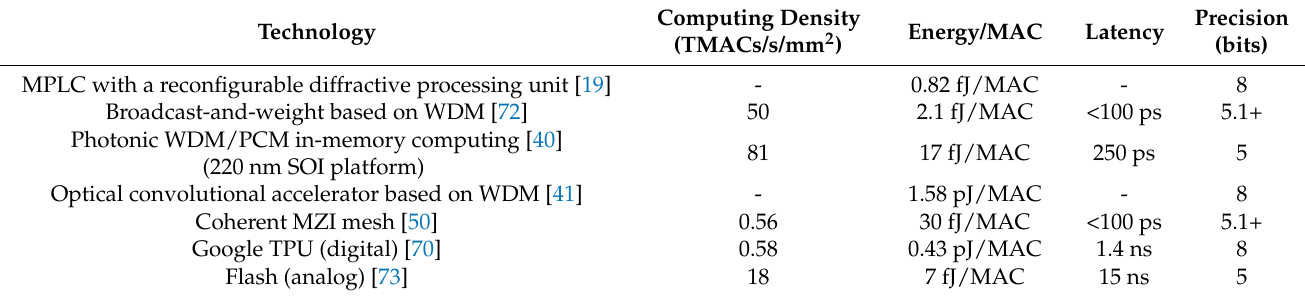
Table 1. Comparison of different photonic AI accelerators with well-known analog and digital electronic hardware. Computing Technology